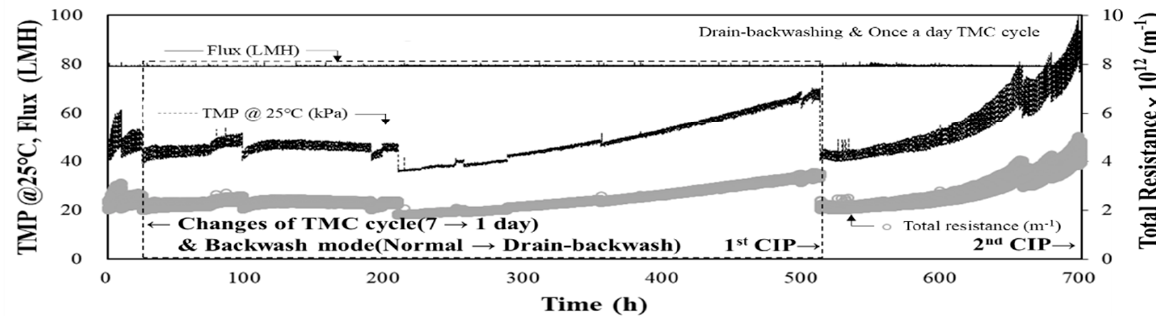
Figure 5. TMP and total resistance during the operation of MF-alone process with high-turbidity raw water (max. turbidity = 76.9 NTU, flux =80 LMH) .